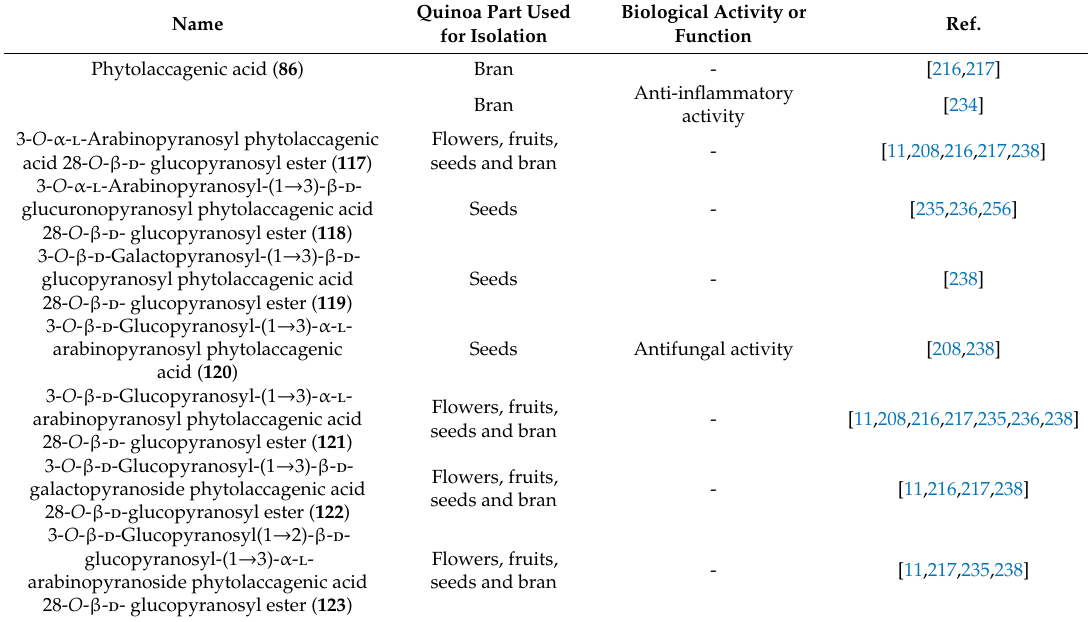
Table 13. Phytolaccagenic acid derivatives and their biological activities or